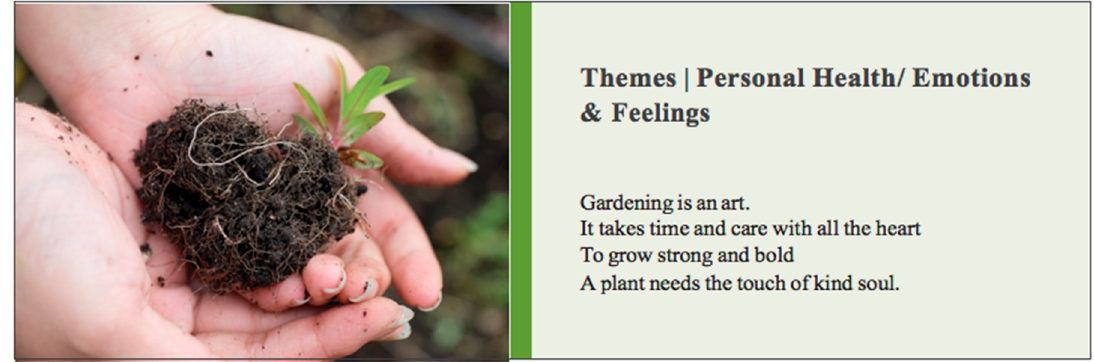
Figure 3. Photovoice artifact #3.